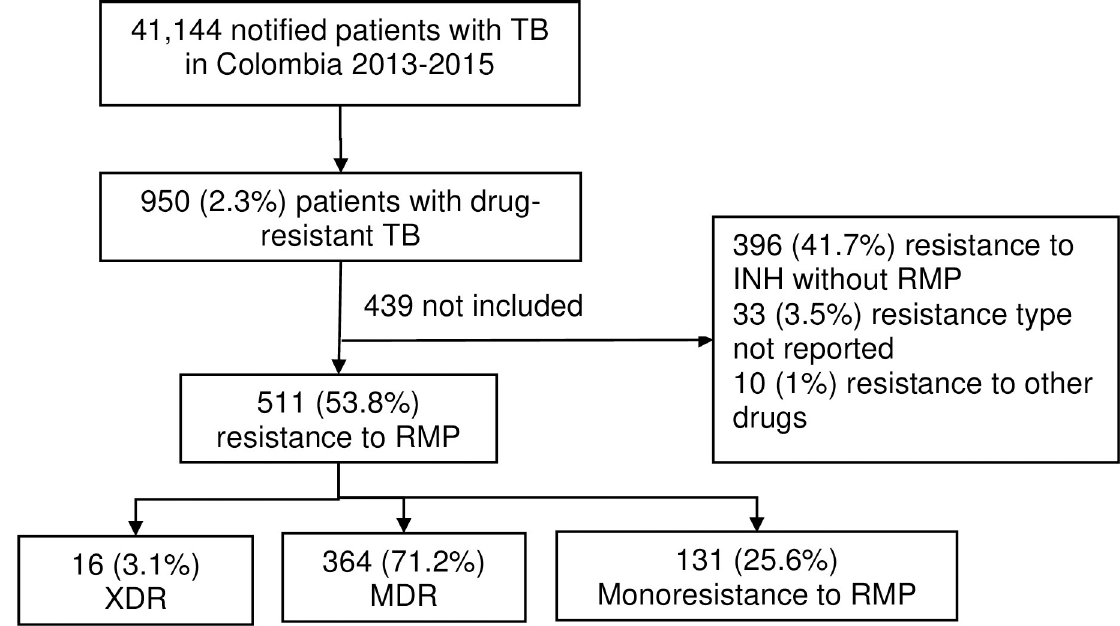
Fig 1. Flowchart of the selected study population with MDR/RR-TB in Colombia, 2013–2015. (TB: tuberculosis; XDR: extensive drug resistance; MDR: multidrug resistance; RMP: rifampicin; INH: isoniazid; INH without RMP: mono- or polyresistance to isoniazid that does not include rifampicin; other resistance: resistance to any antituberculosis drug other than RMP and INH).